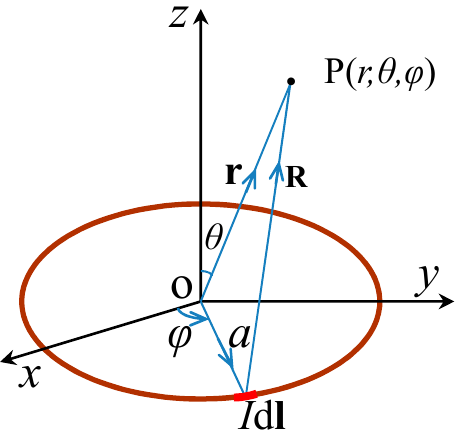
Figure 2. Stress concentration zone model.